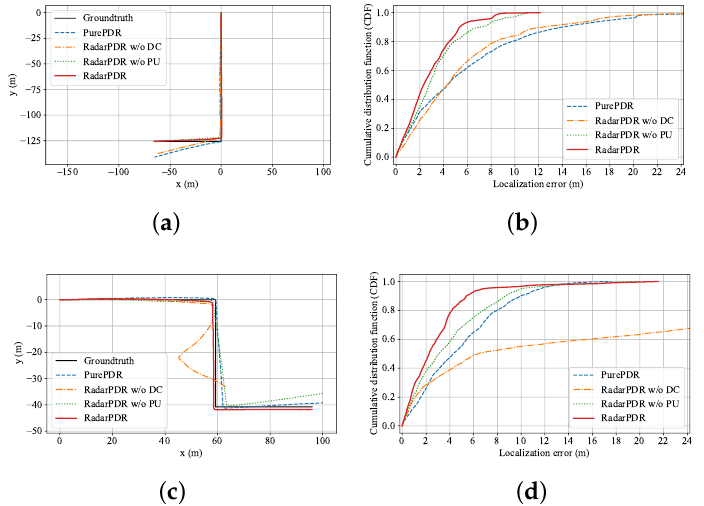
Figure 12. Trajectory and its CDF of ALE. ( a ) average trajectory of all the tests on the L-shape route; ( b ) the localization error CDF of all the testing trajectories on the L-shape route; ( c ) average trajectory of all the tests on the Z-shape route; ( d ) the localization error CDF of all the testing trajectories on the Z-shape